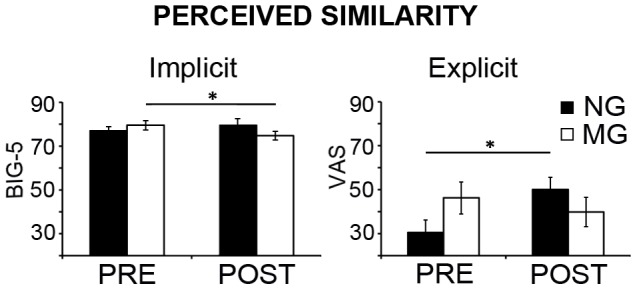
Indices of perceived similarity in the two groups before and after the interpersonal manipulation and the joint grasping task.The graphs report the indexes of Implicit (left) and Explicit (right) Perceived similarity reported by participants before (PRE) and after (POST) they underwent both the Interpersonal manipulation and the Joint grasping task. While implicit judgments extracted from the BIG-5 personality questionnaire (see main text) significantly decreased in the MG as a consequence of the Interpersonal manipulation, explicit judgements of perceived similarity (collected through a Visual Analogue Scale) significantly increased in the NG as a positive consequence of the cooperative motor interaction. Thus, both indices followed a similar pattern, though Implicit judgements were more sensitive to detect the induced negative attitude towards the partner in MG. Error bars indicate s.e.m. (*) p<.05.